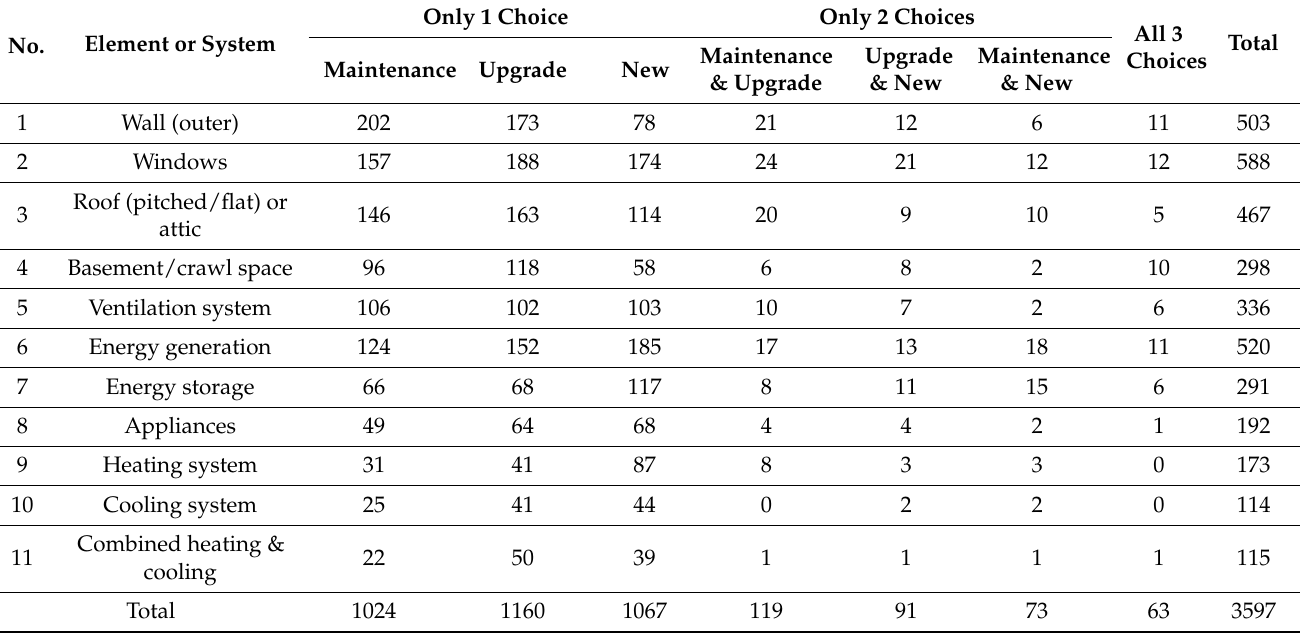
Table 4. Distribution of combination of choices per each element (out of 11) chosen.